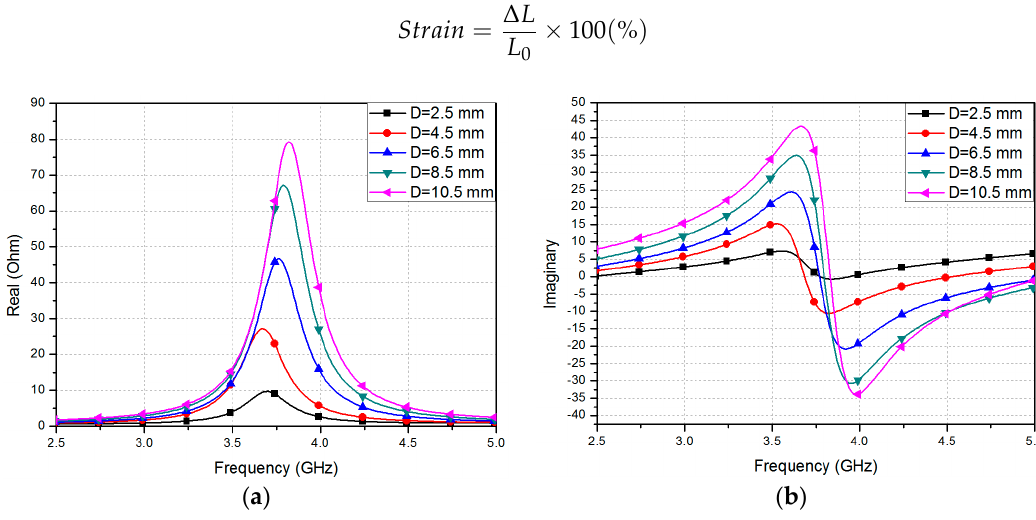
Figure 2. Simulated input impedance at different location of D; ( a ) real part and ( b ) imaginary part.